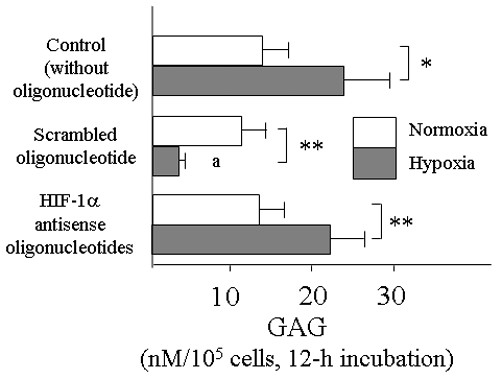
Glycosaminoglycan production and apoptosis induction in HIF-1α-deficient chondrocytes. In the scrambled oligonucleotide-treated groups, the amount of glycosaminoglycan (GAG) produced by cultured chondrocytes was higher under hypoxic conditions than under normoxic conditions. Under hypoxic conditions, GAG levels decreased in chondrocytes deficient in hypoxia-inducible factor 1α (HIF-1α). Statistical differences were calculated using data from four independent experiments. aP < 0.01, control oligonucleotide hypoxia vs HIF-1α-antisense hypoxia; *P < 0.05; **P < 0.01.